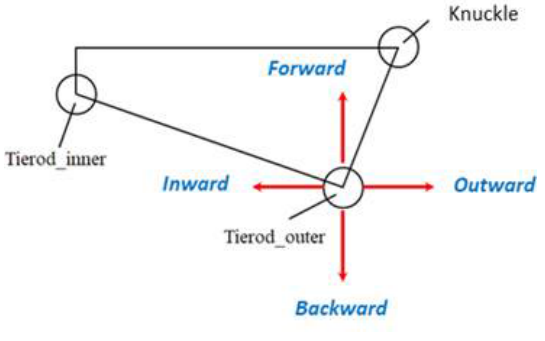
Table 4. Sprung mass at full load.